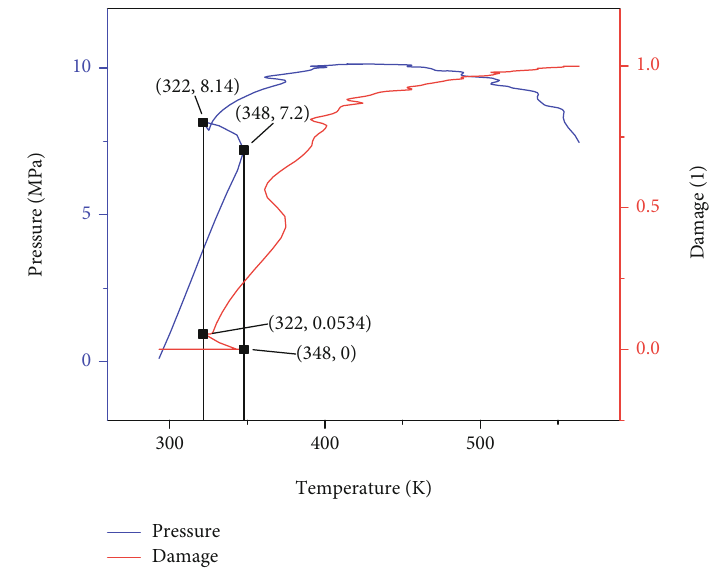
Figure 10: T - p - d curve of group